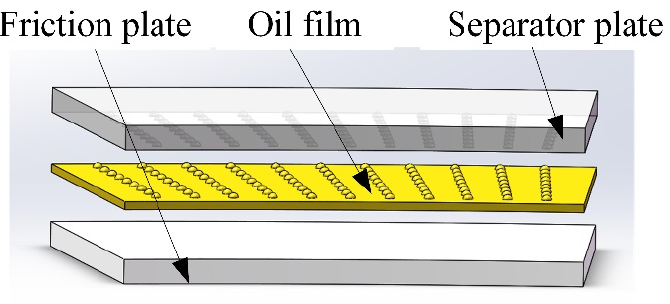
Figure 5. Schematic diagram of friction pair structure.